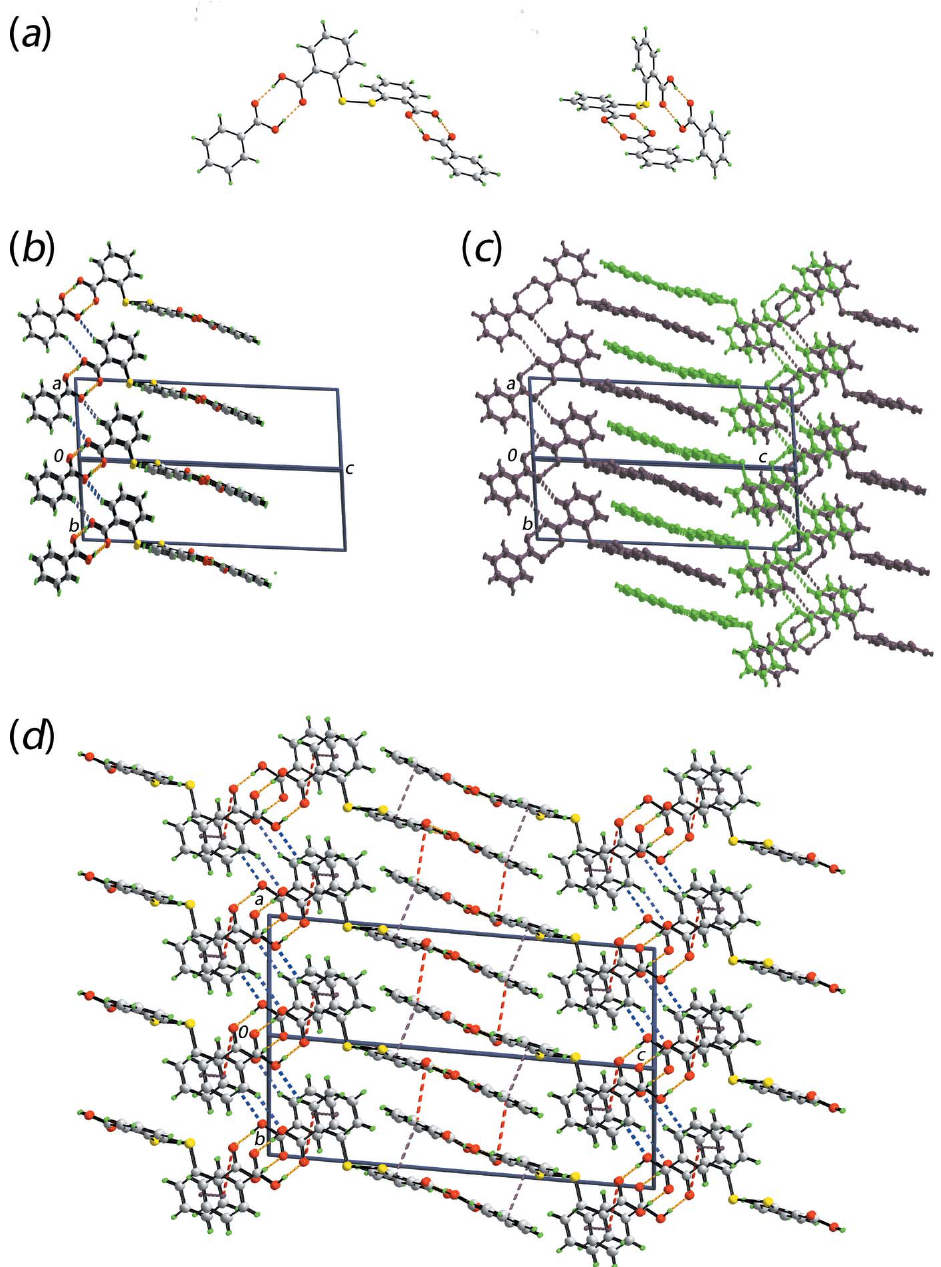
Figure 2 Molecular packing in co-crystal (I): ( a ) two views of the three-molecule aggregate with the the hydroxy-O—H (cid:2)(cid:2)(cid:2) O(carbonyl) hydrogen bonds shown as orange dashed lines, ( b ) supramolecular layer in the ab plane where the three-molecule aggregates of ( a ) are linked by DTBA-C—H (cid:2)(cid:2)(cid:2) O(hydroxy-BA), BA-C—H (cid:2)(cid:2)(cid:2) O(hydroxy-DTBA) interactions, shown as blue dashed lines, ( c ) mutual orthogonal inter-digitation of symmetry-related layers and ( d ) a view of the unit-cell contents with (cid:2) – (cid:2) and C—O (cid:2)(cid:2)(cid:2) (cid:2) interactions shown as purple and red dashed lines,